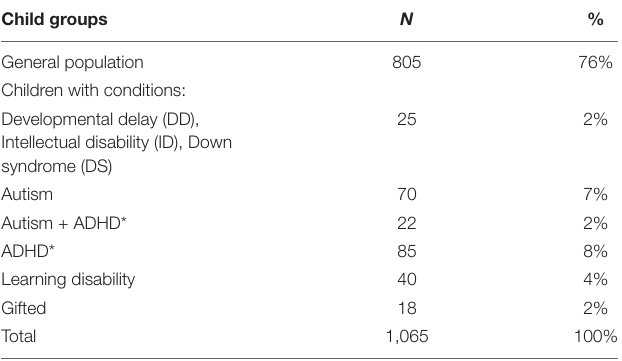
TABLE 1 | Summary of the study sample.